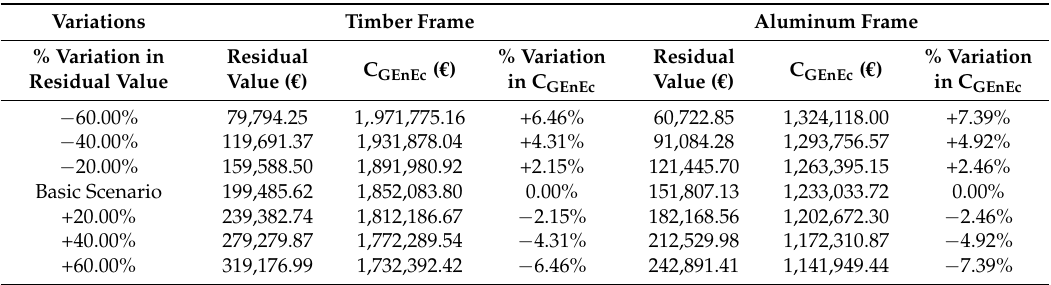
Table 11. Sensitivity analysis with decreased/increased residual values.